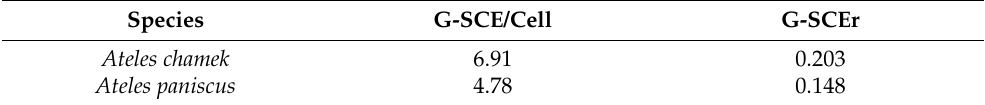
Table 1. G-SCE quantification in two species of non-human primates, A. chamek and A. paniscus . G-SCE/cell: average number of genomic sister chromatid exchange per cell. G-SCEr: number of G-SCEs relative to the total number of chromosomes of all metaphases scored.